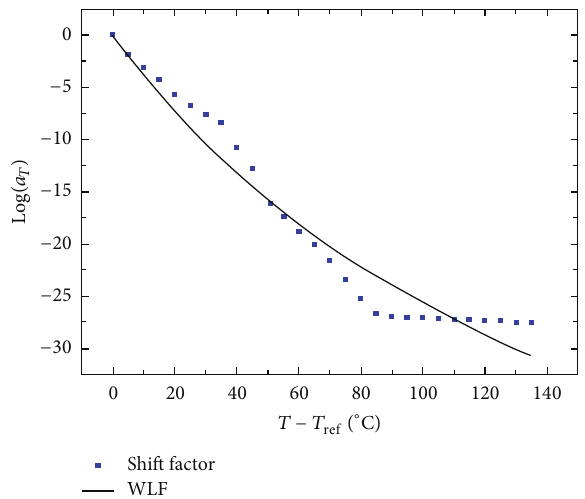
Figure 4: Comparison between the actual shift factor determined from EVA experiments (dots) and the expected Williams-Landel- Ferry WLF shift function (solid curve) for the application of the time-temperature superposition principle (adapted from [14]). The = − 20 ∘ reference temperature is 𝑇 ref